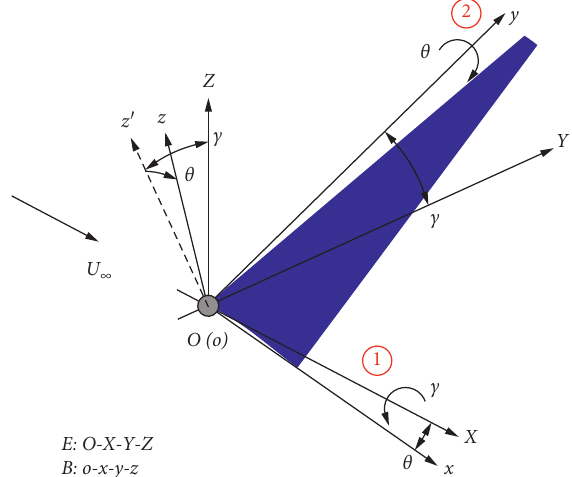
Figure 3: Coordinate systems of a flapping and pitching wing.